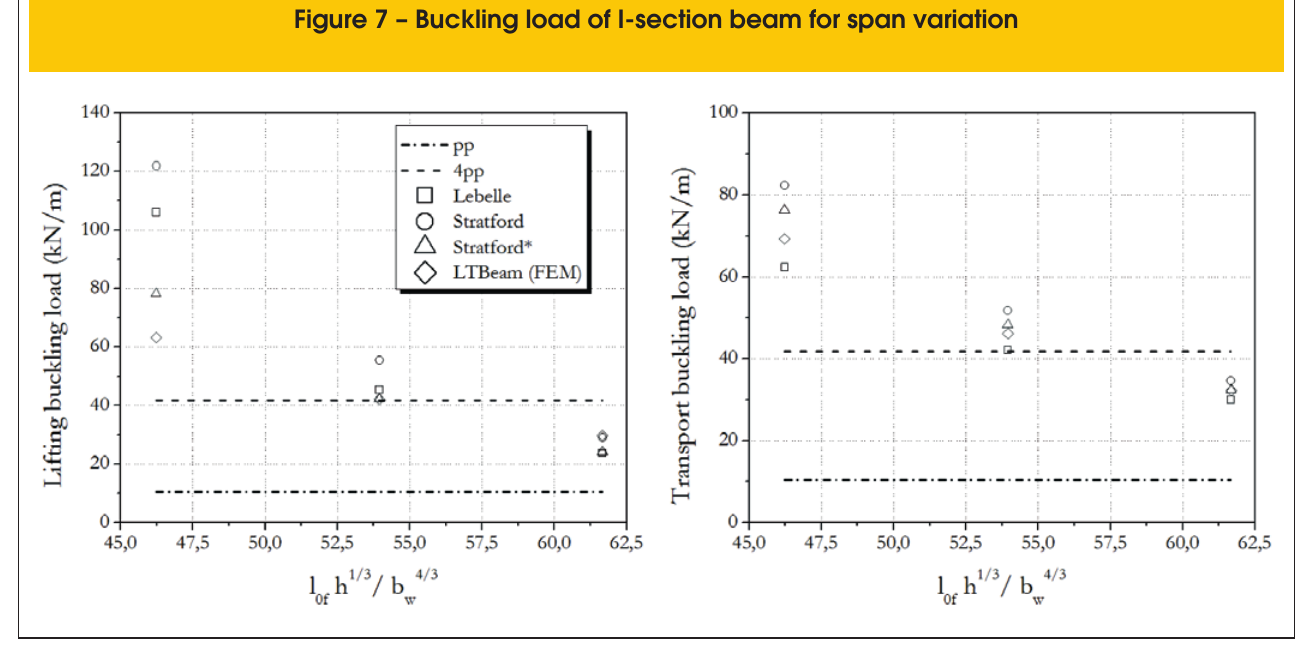
Figure 7 – Buckling load of I-section beam for span